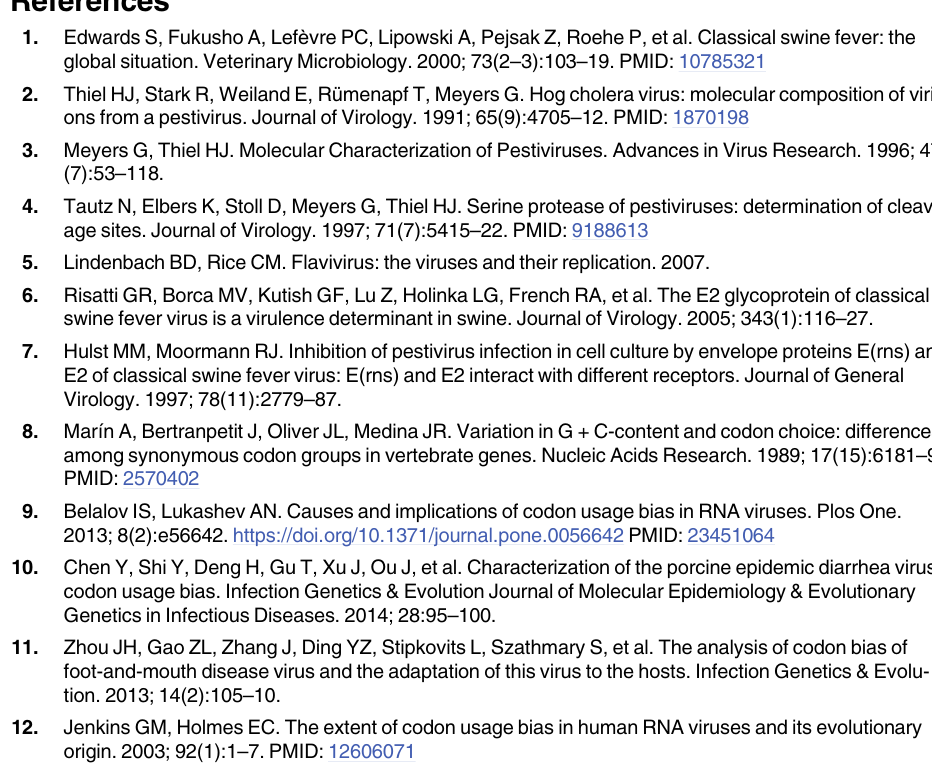
S1 Table. The detail information of the 140 collected sequences of E2 gene of CSFV. S2 Table. The nucleotides composition of the 140 sequences of E2 gene of